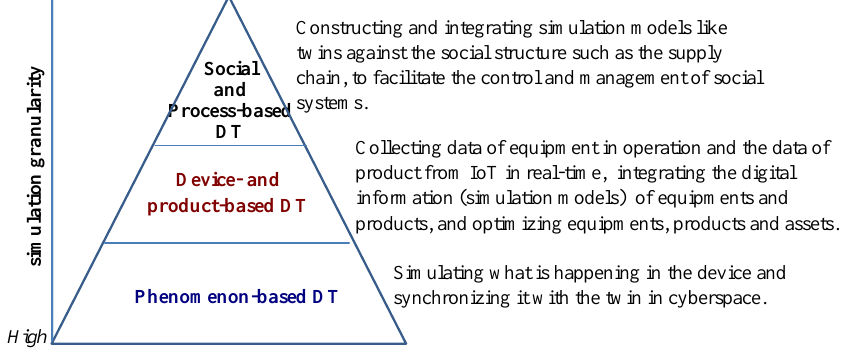
Figure 2. Hierarchical structure of digital twins.